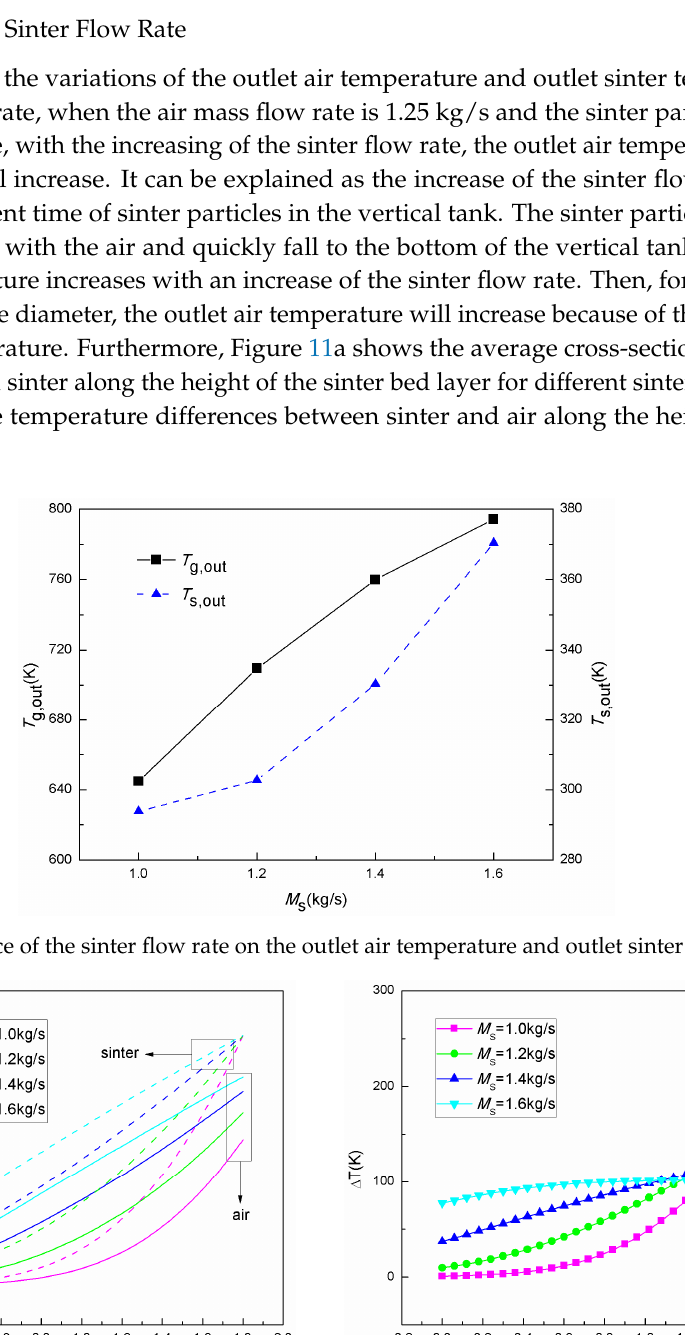
Figure 9. Influence of the air flow rate on exergy destruction caused by heat transfer and caused by fluid flow.